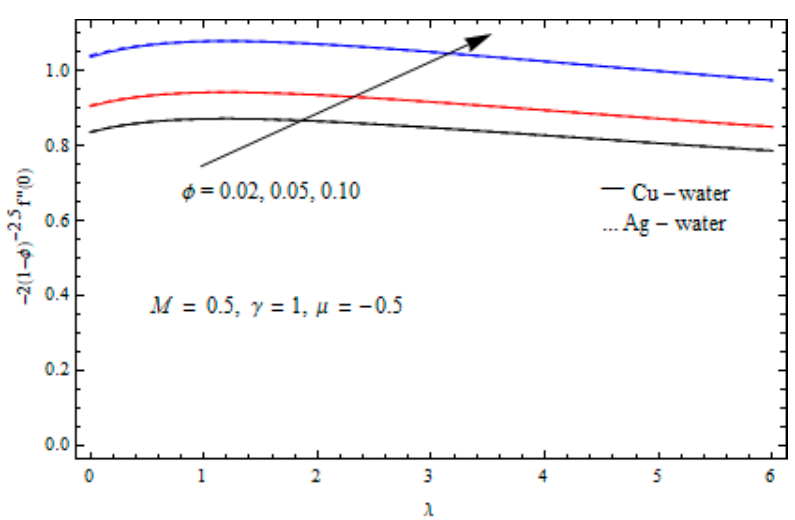
φ Figure 2. Effects of φ on skin friction coefficient in the presence of second slip. on skin friction coefficient in the presence of second slip. Figure 2. Effects of